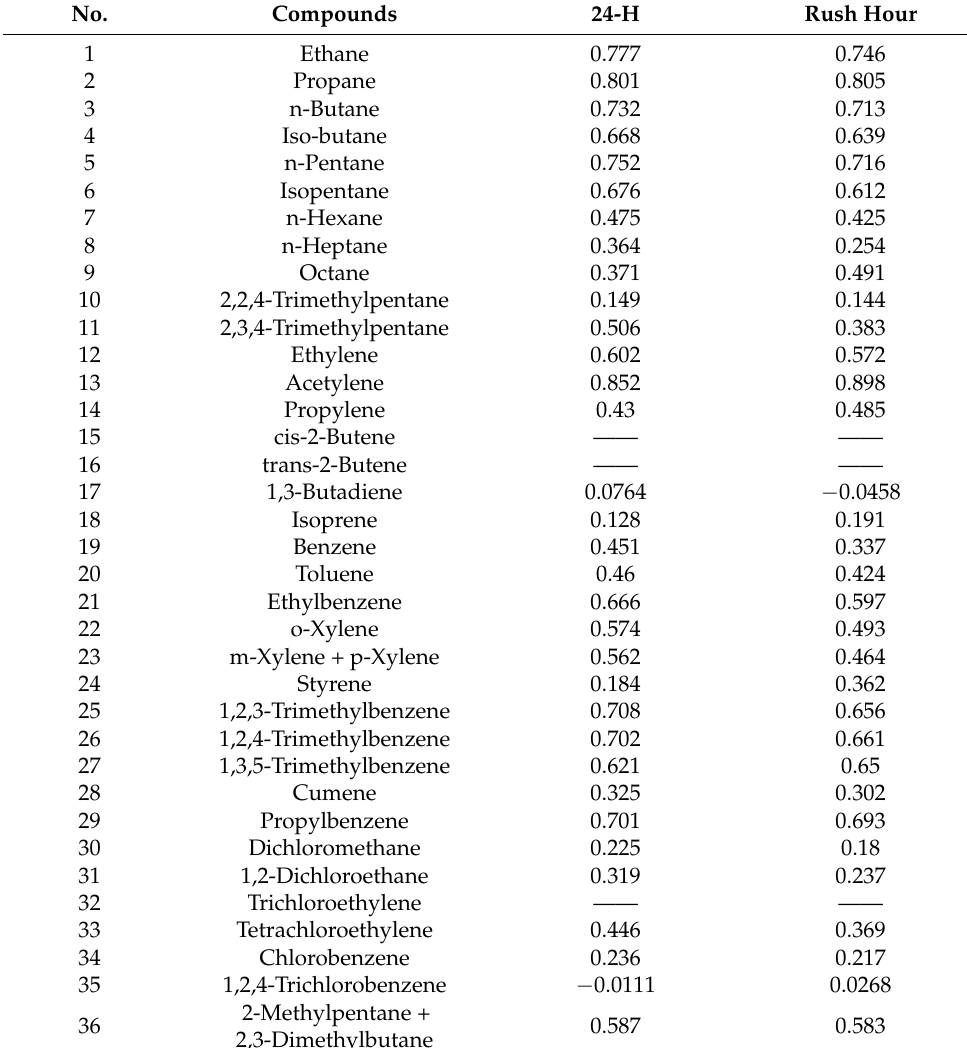
Table 1. Correlation coefficient between BC and 36-VOCs in December